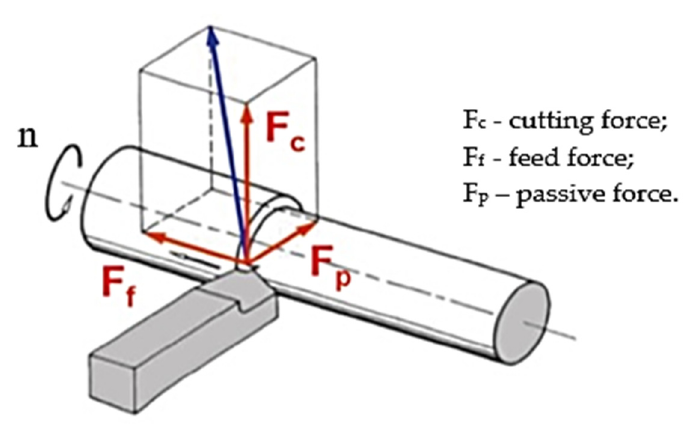
Figure 3. The components of the cutting force at longitudinal turning.